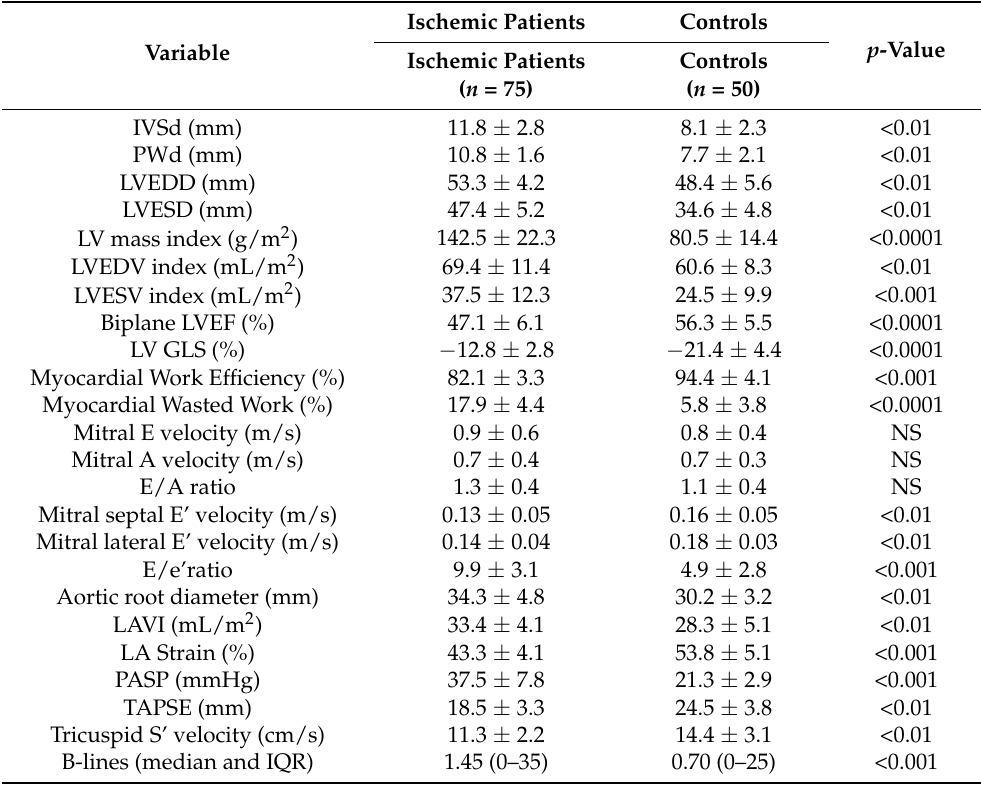
Table 2. Baseline echocardiographic measurements in the ischemic patients and control group.